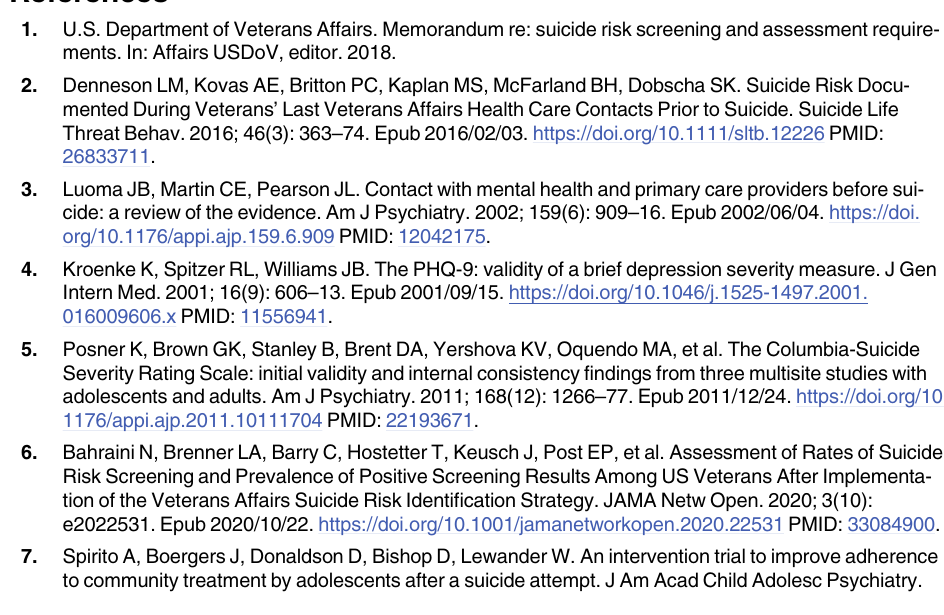
S2 Fig. Fiscal year 2020 engagement. The gray bars represent having received mental health treatment in past year. The white bars represent not having received mental health treatment in the past year. Error bars represent standard error. C-SSRS = Columbia-Suicide Severity Rat- ing